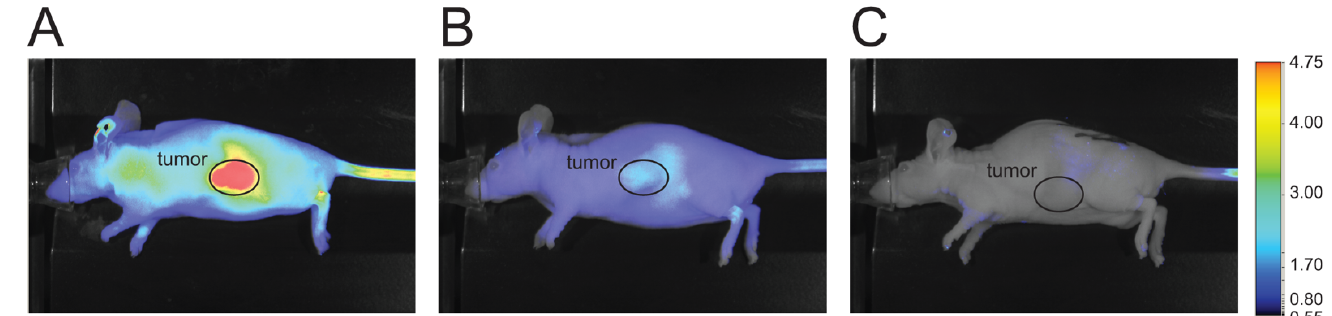
Figure 2. The α V β 3 integrin binder shows tumor homing in 786-O RCC tumor-bearing mice. Tumor homing of ( A ) the IR800-coupled α V β 3 binder conjugate, ( B ) the non-binding control conjugate, or the ( C ) carboxylate dye control in 786-O tumor-bearing mice as detected by near-infrared imaging. The color scale shows arbitrary near-infrared fluorescence units as displayed by the Pearl ® Imager software. A representative image from each treatment group is shown ( n = 3).